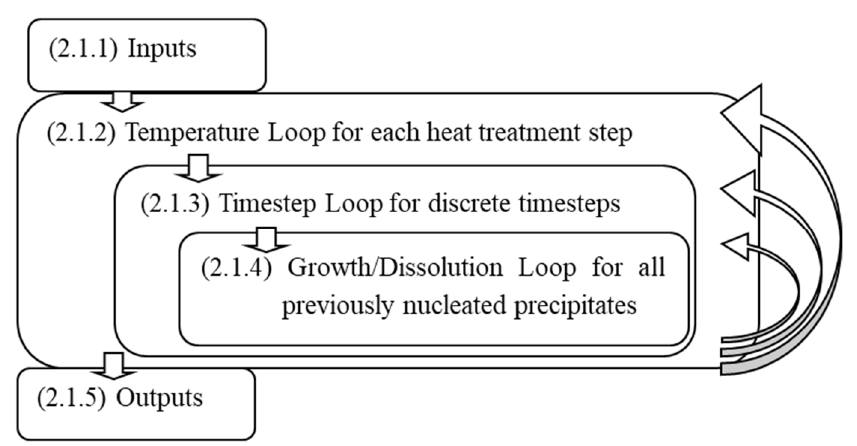
Figure 1. Visual representation of the distinct sections of the precipitation and strengthening model. The model itself is available in the Supplementary Material.